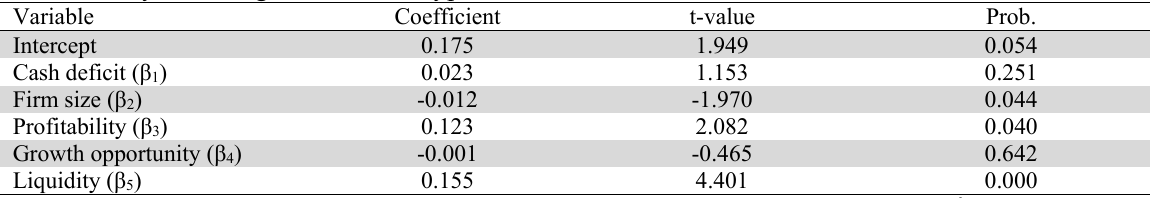
The summary of testing the first sub-hypothesis